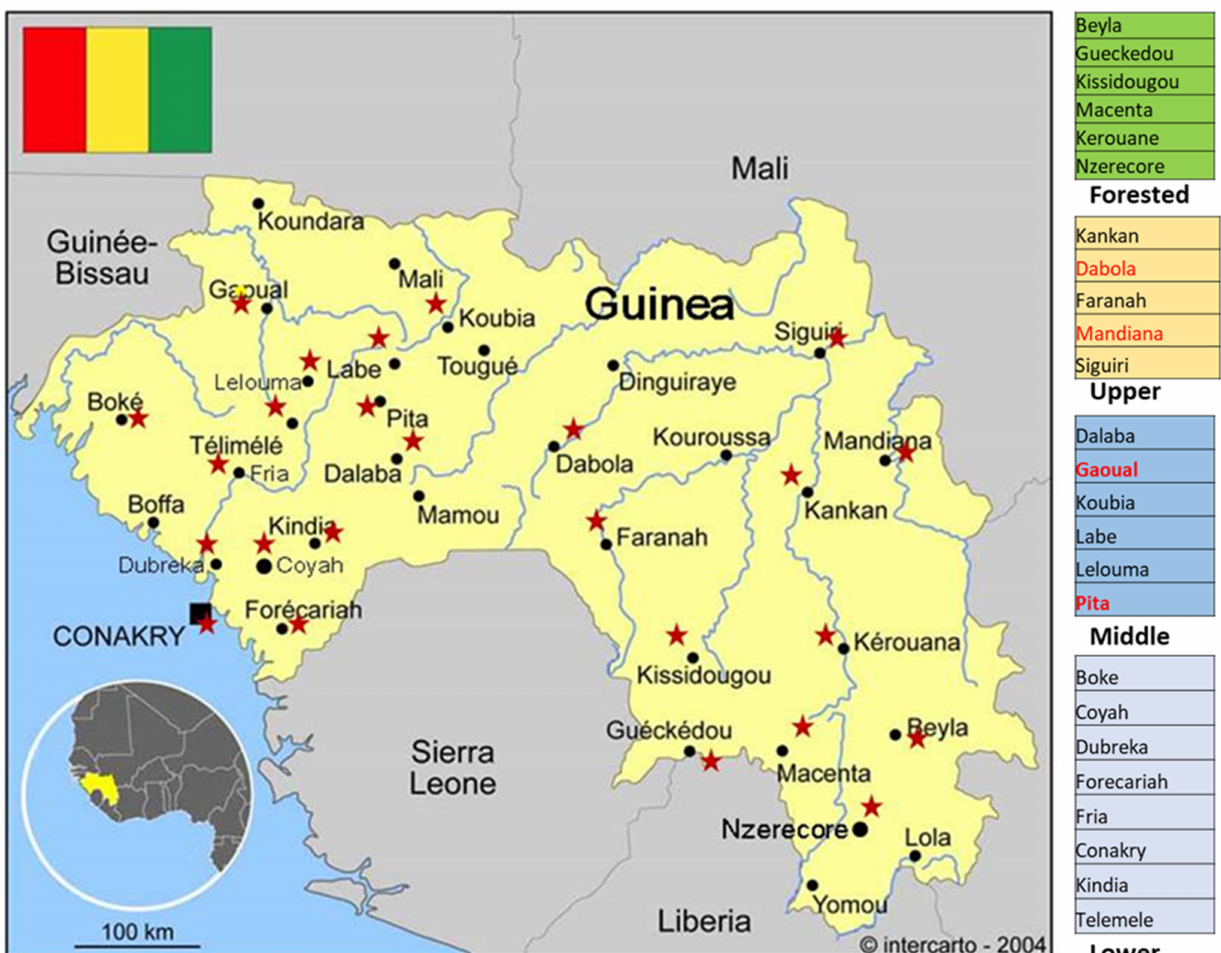
Figure 1. Map of Guinea. Districts where clinical samples were collected are marked with red